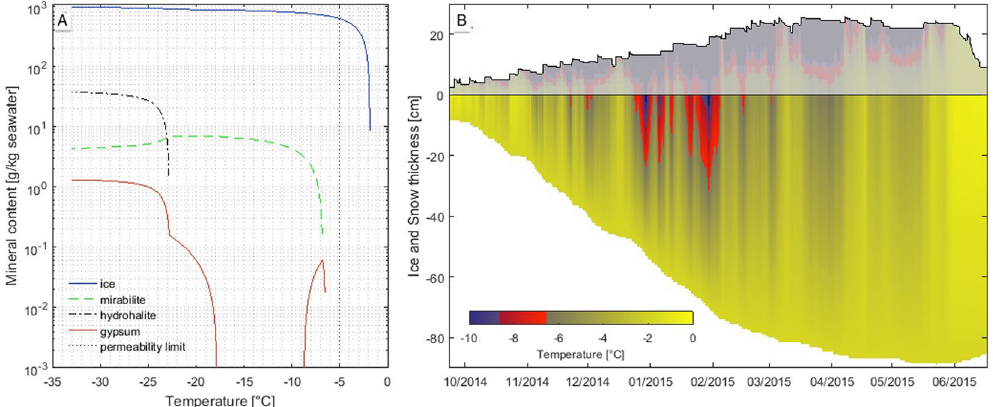
Figure 3. Gypsum formation in sea ice: ( A ) Temperature dependence of the precipitation of gypsum and other minerals during the freezing of standard seawater, as calculated by FREZCHEM 30 . ( B ) Evolution of sea-ice temperature, as modelled by SNOWPACK 58 . The possible window of gypsum precipitation is highlighted by the red part of the colour bar. Snow temperatures are shaded in white to illustrate that no gypsum precipitated from